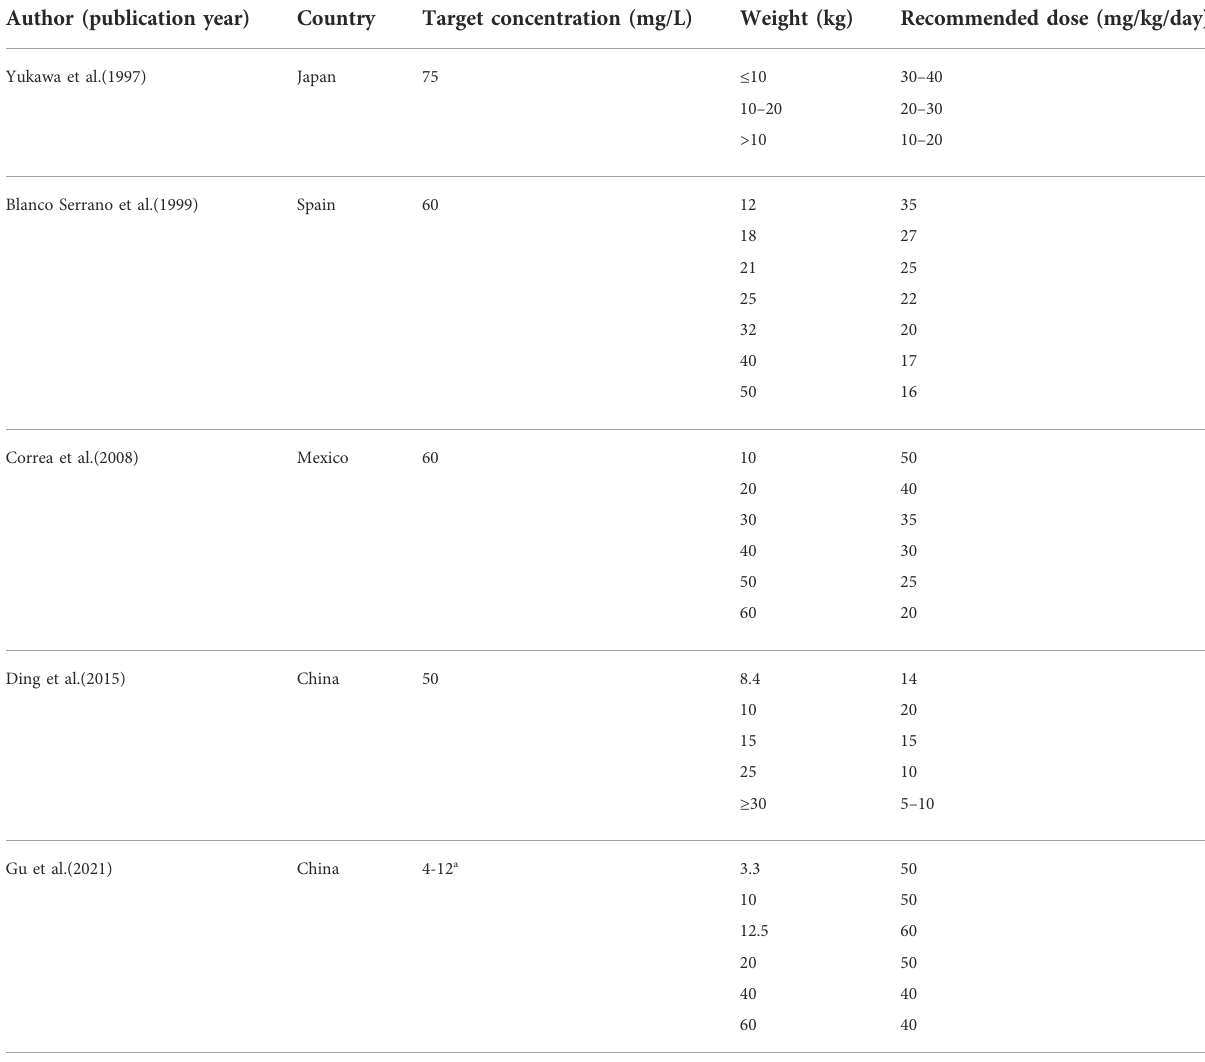
TABLE 6 Results of doses simulations from published population pharmacokinetic models in pediatric patients with